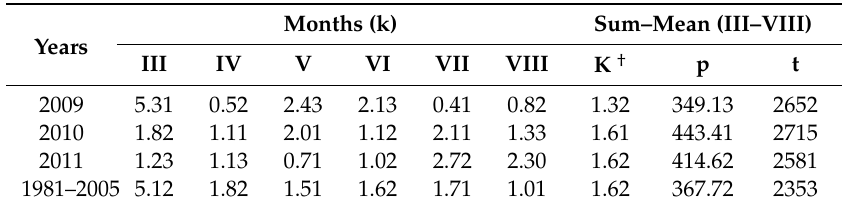
Table 3. Selyaninov’s hydrothermal coe ffi cient of the sum of rainfall (mm) and mean air temperature ( ◦ C) of the vegetation periods (2009–2011) and the long-term averages